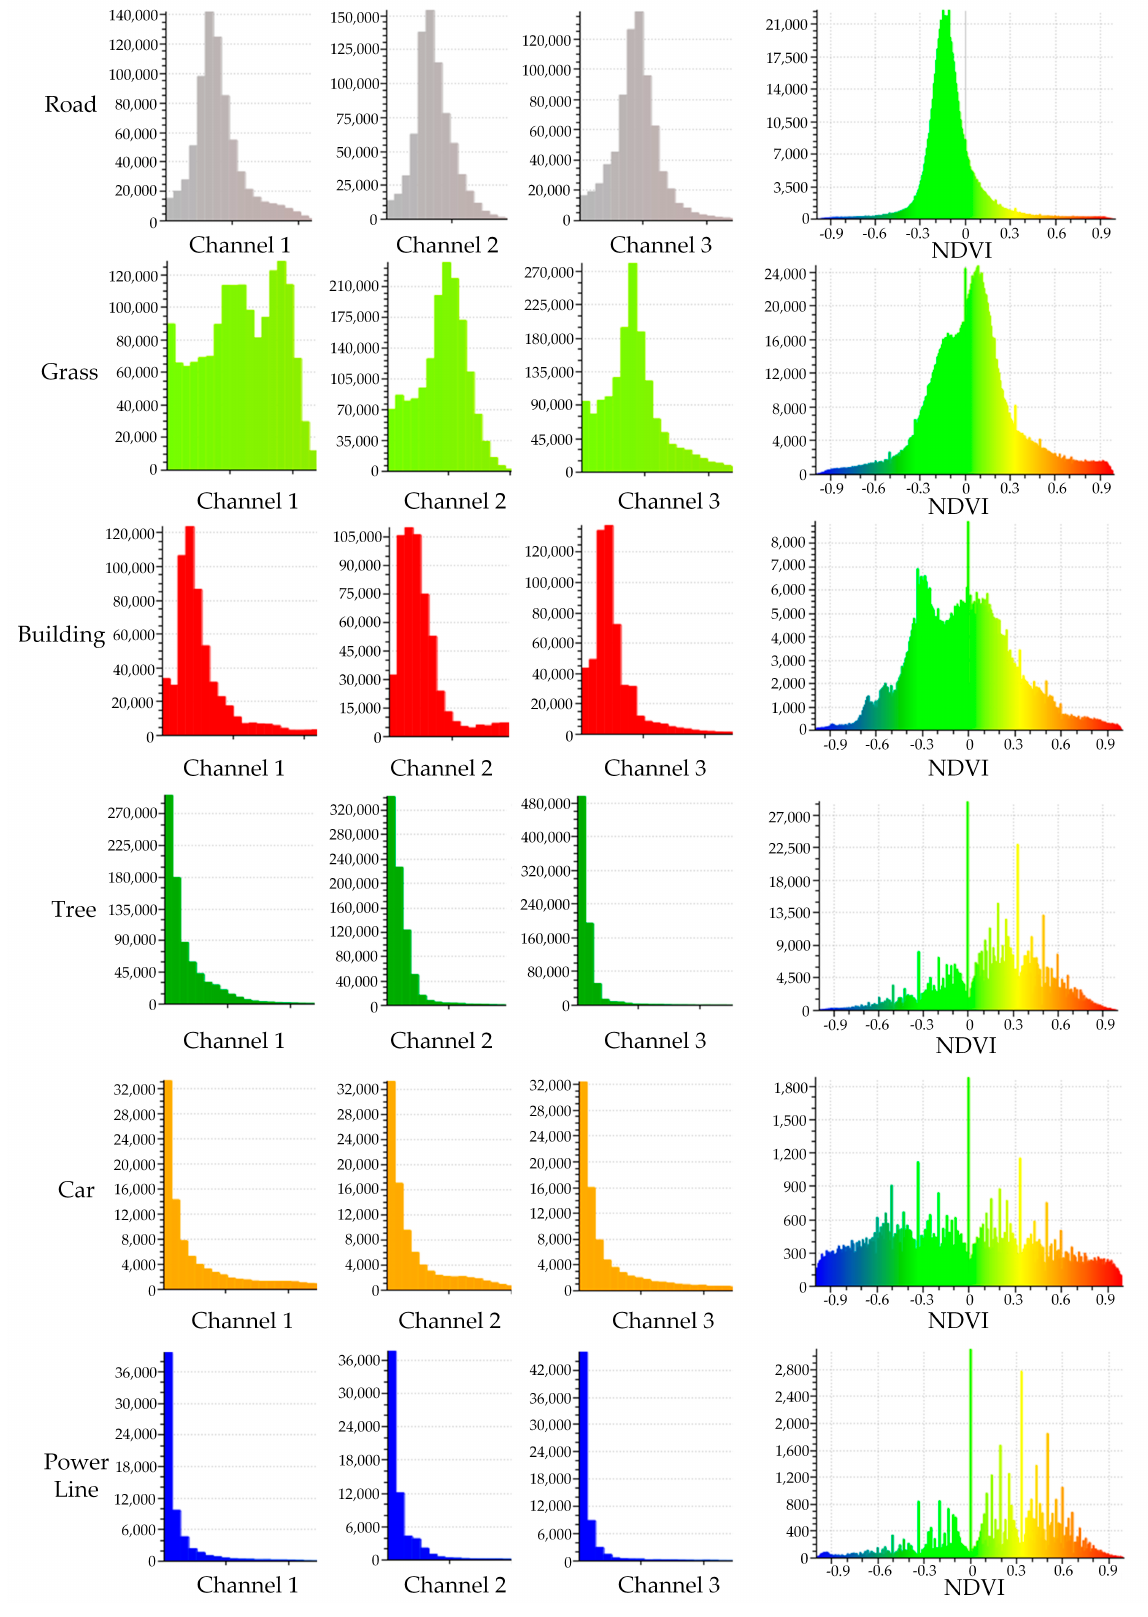
Figure 9. Histograms of four feature classes at Titan 3-channel information and NDVI.